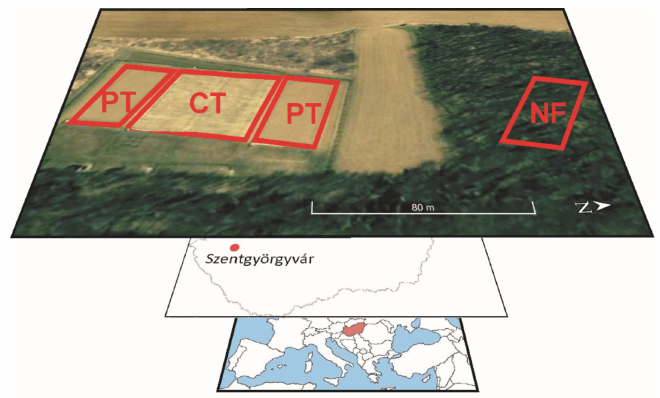
Figure 1. Location of the study site with ploughing tillage (PT) and conservation tillage (CT) plots and the native forest (NF)